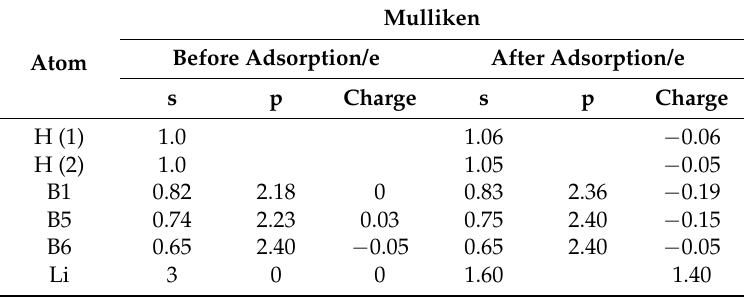
Table 2. Mulliken population analysis of the Li- β 12 -borophene before and after one H 2 molecule adsorption. Mulliken Before Adsorption/e After Adsorption/e Atom s p Charge s p Charge H (1) 1.0 1.06 − 0.06 H (2) 1.0 1.05 − 0.05 B1 0.82 2.18 0 0.83 2.36 − 0.19 B5 0.74 2.23 0.03 0.75 2.40 − 0.15 B6 0.65 2.40 − 0.05 0.65 2.40 − 0.05 Li 3 0 0 1.60